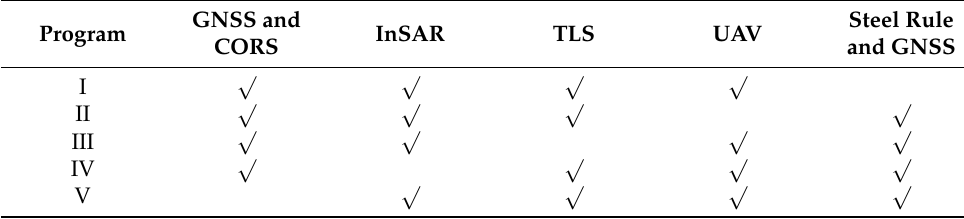
Table 4. Monitoring method combination comparison